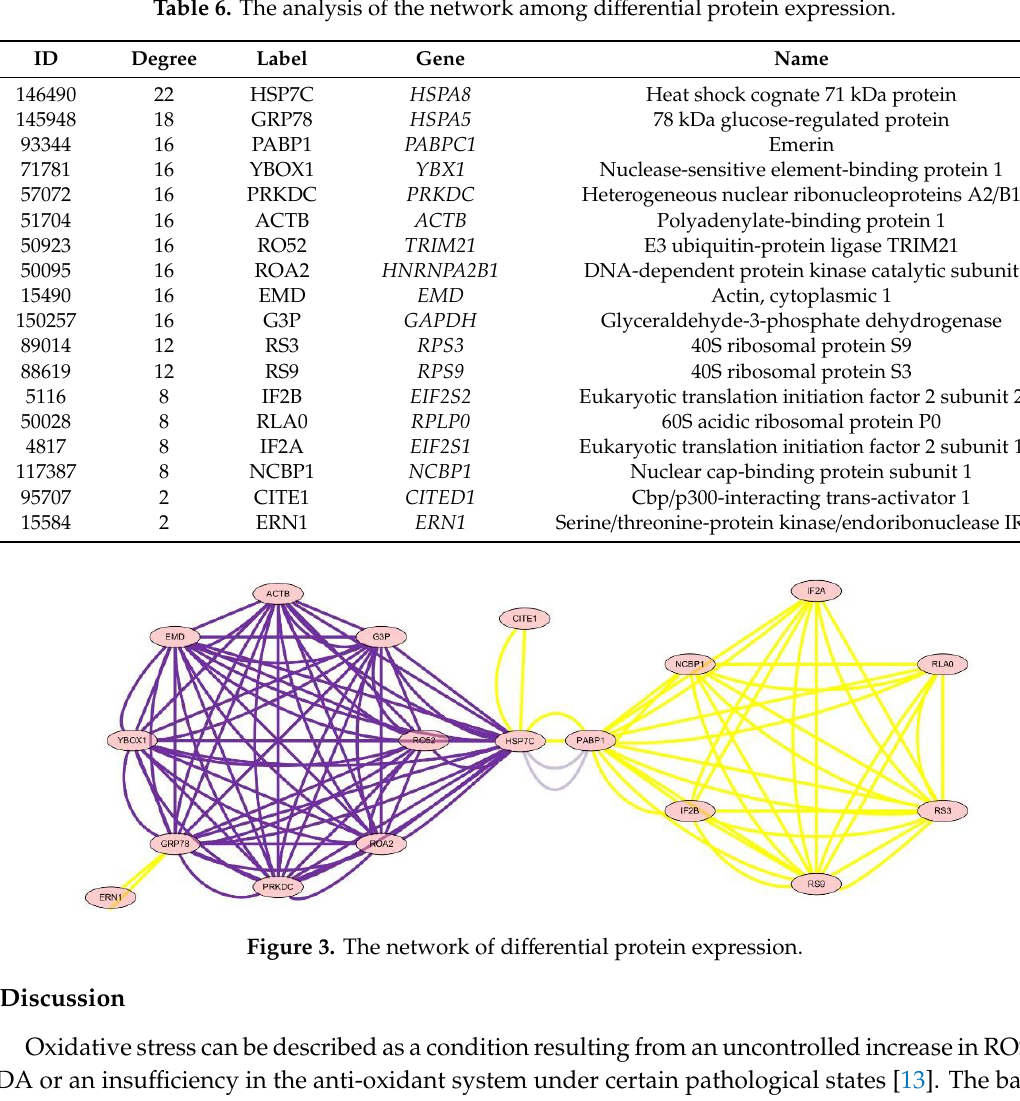
Table 6. The analysis of the network among differential protein expression.